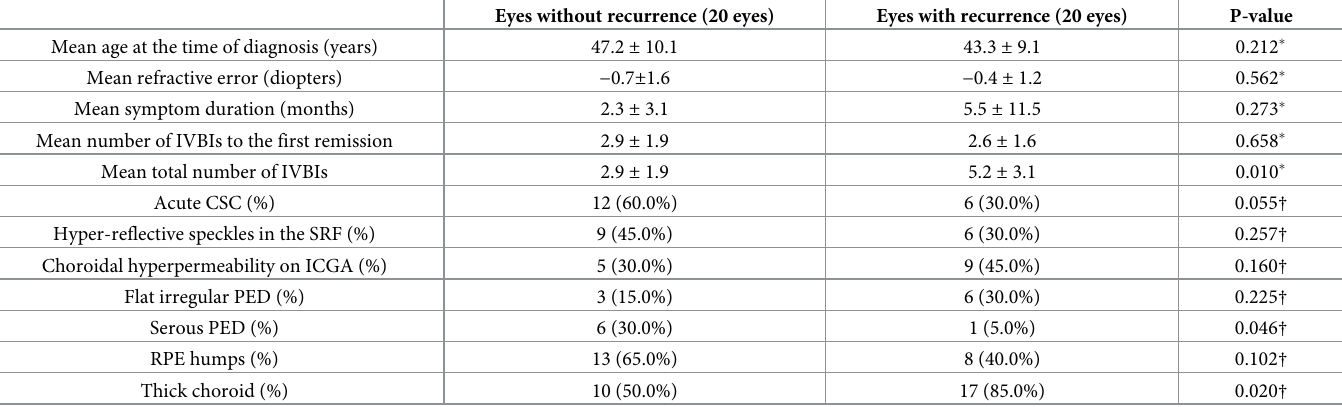
Table 2. Comparison of baseline characteristics between eyes with and without recurrence after complete remission with intravitreal bevacizumab injections (IVBIs) for central serous chorioretinopathy.